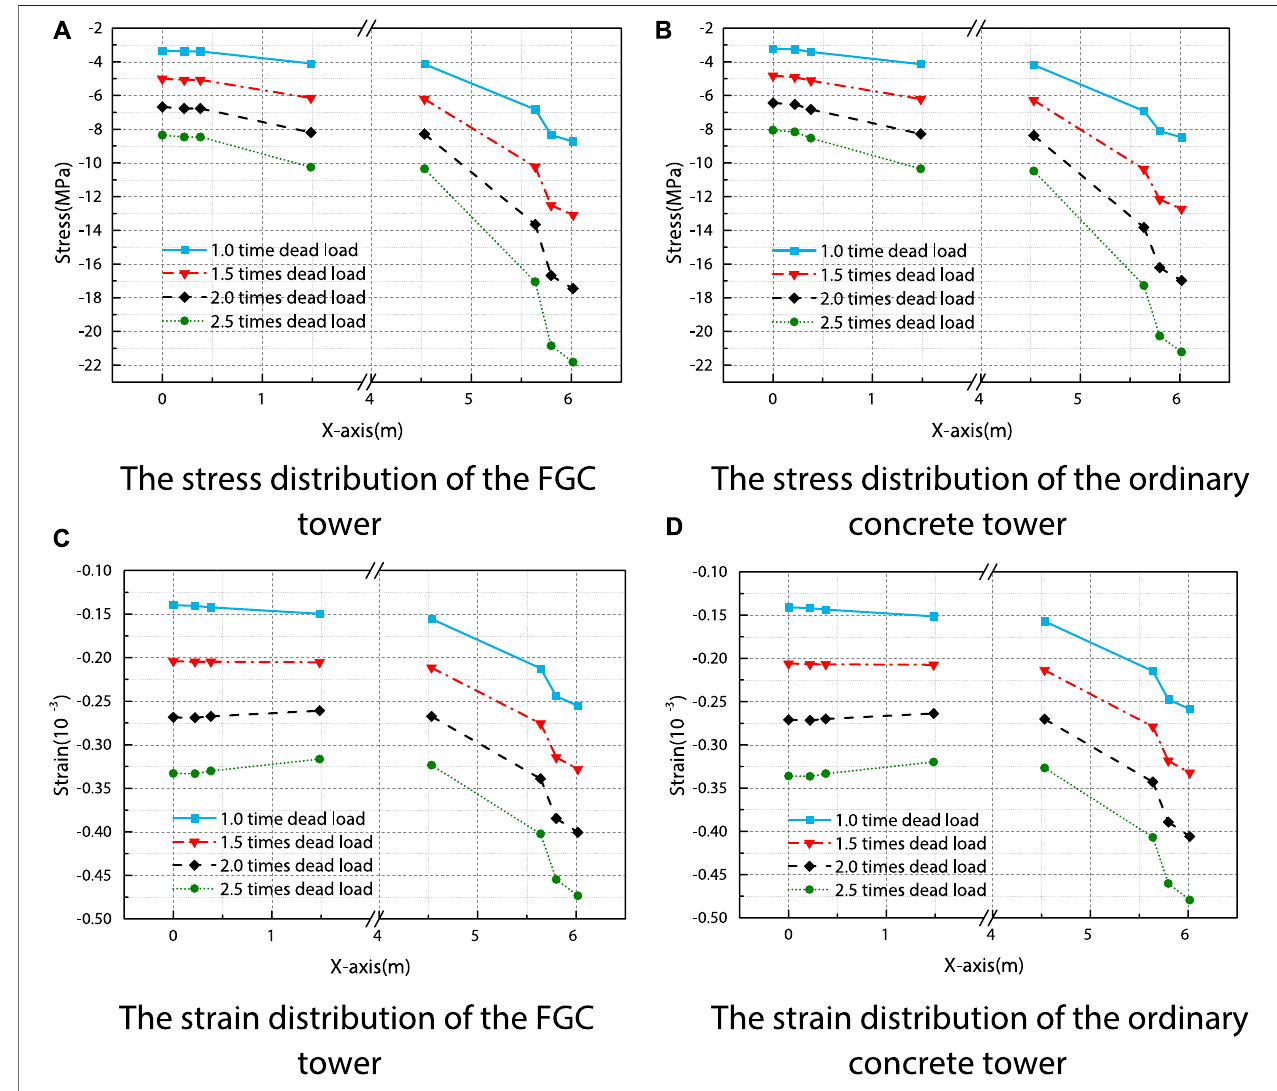
FIGURE 7 | The midline stress and strain distribution of the cross-section at the height of 144.8 m. (A) The stress distribution of the FGC tower. (B) The stress distribution of the ordinary concrete tower. (C) The strain distribution of the FGC tower. (D) The strain distribution of the ordinary concrete tower.